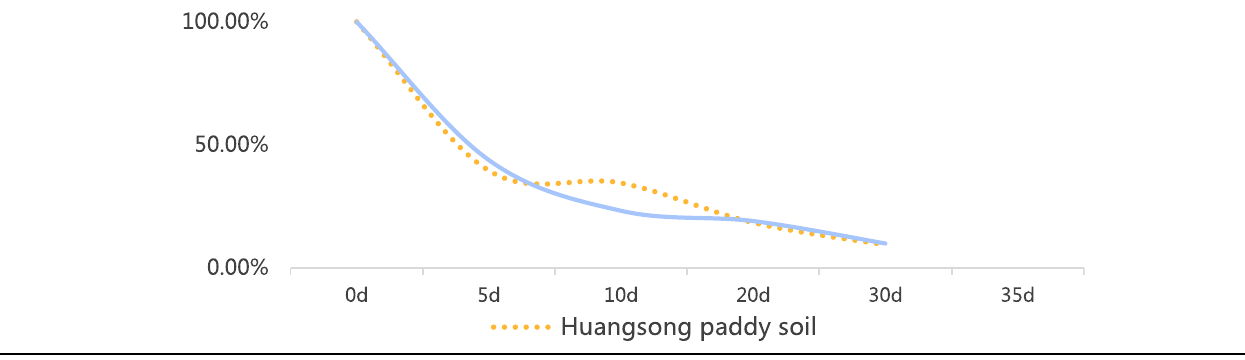
Evenness of bacteria community Diversity of bacteria community ) in rhizosphere soil ( D sh